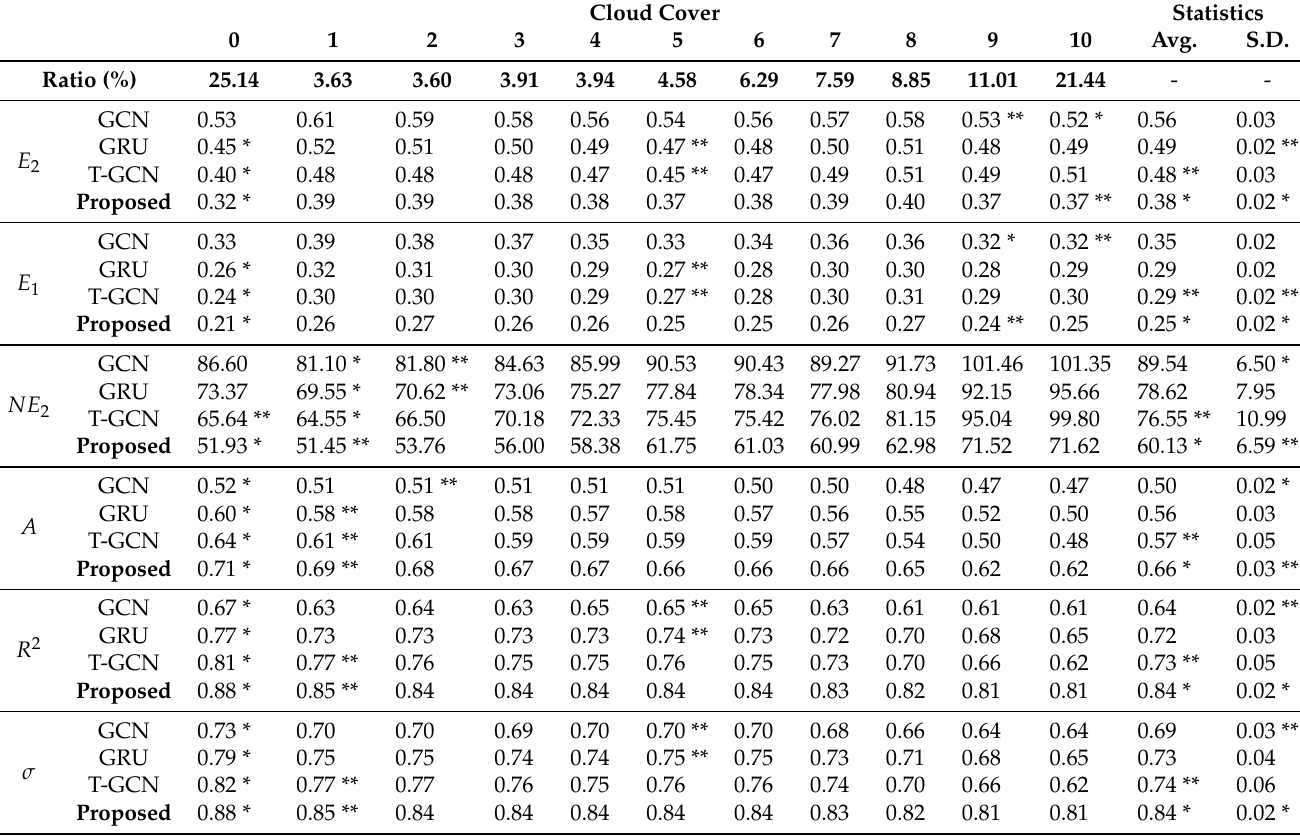
Table 4. Performance of the proposed and existing models according to cloud cover. The first row indicates the degree of cloud cover from 0 to 10. The second row presents the distribution of cloudiness levels in the experimental dataset. In the third to thirteenth columns, * and ** indicate cloudiness levels that each forecasting model had the best and second-best performances, respectively. Additionally, in the last two columns, * and ** refer to forecasting models that showed the best and second-best performances on average and the lowest and second-lowest standard deviation, respectively. The hyper-parameters were set as L o = 24, L p = 24, N = 4, and θ V =